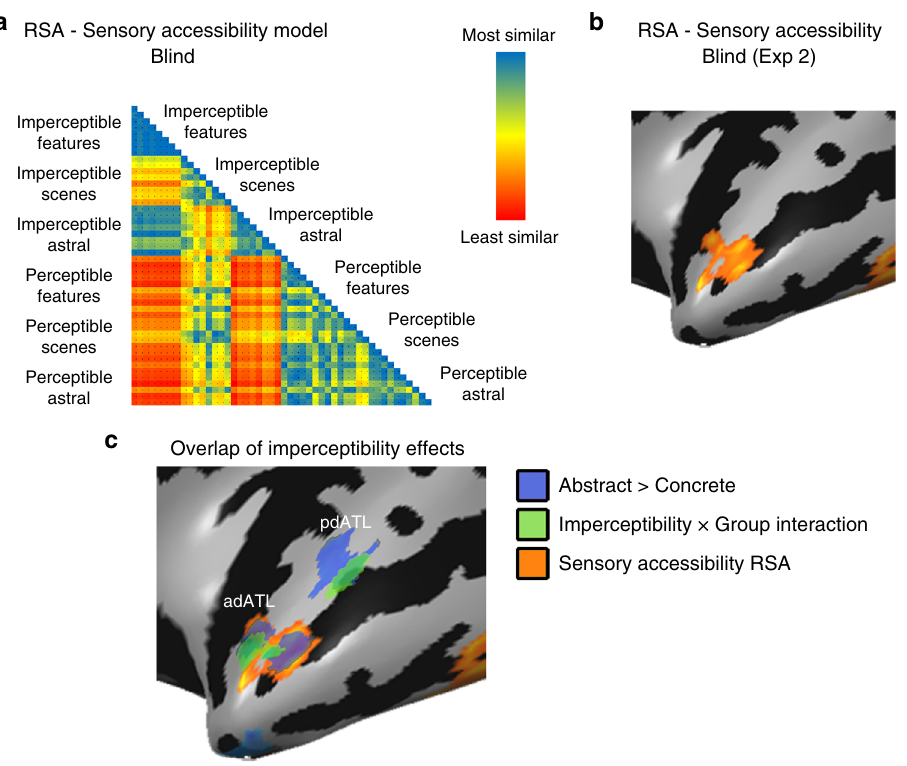
Fig. 3 Concepts ’ Imperceptibility is mapped in left dorsal ATL pattern. a , b Multivariate representational similarity analysis (RSA) was computed comparing a behavioral matrix based on ratings of the blind subjects of the sensory perceptibility of the concepts ( a ; representational dissimilarity matrix) with the neural patterns in Exp. 2 in a searchlight manner across the brain. Sensory perceptibility correlation ( b ) was found in the dorsal ATL, overlapping the effects of imperceptibility X group interaction and abstract concepts preference. For additional control RSA analyses see Supplementary Fig. 4. c The main effects from Figs. 1 – 3 are shown together, to reveal the overlap in the dorsal ATL between preference for abstract concepts (over concrete ones; Fig. 1c; depicted in blue; data from Exp. 1), Imperceptibility X Group interaction (Fig. 2a; depicted in green; data from Exp. 1) and the sensory perceptibility RSA ( b ; depicted in orange; data from Exp.